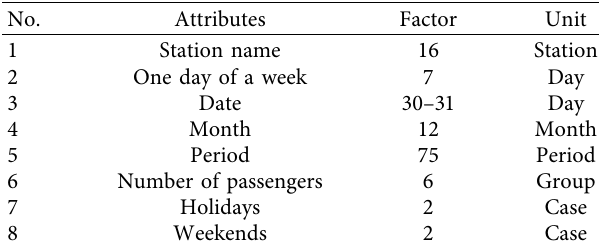
Table 2: Attributes in input data.